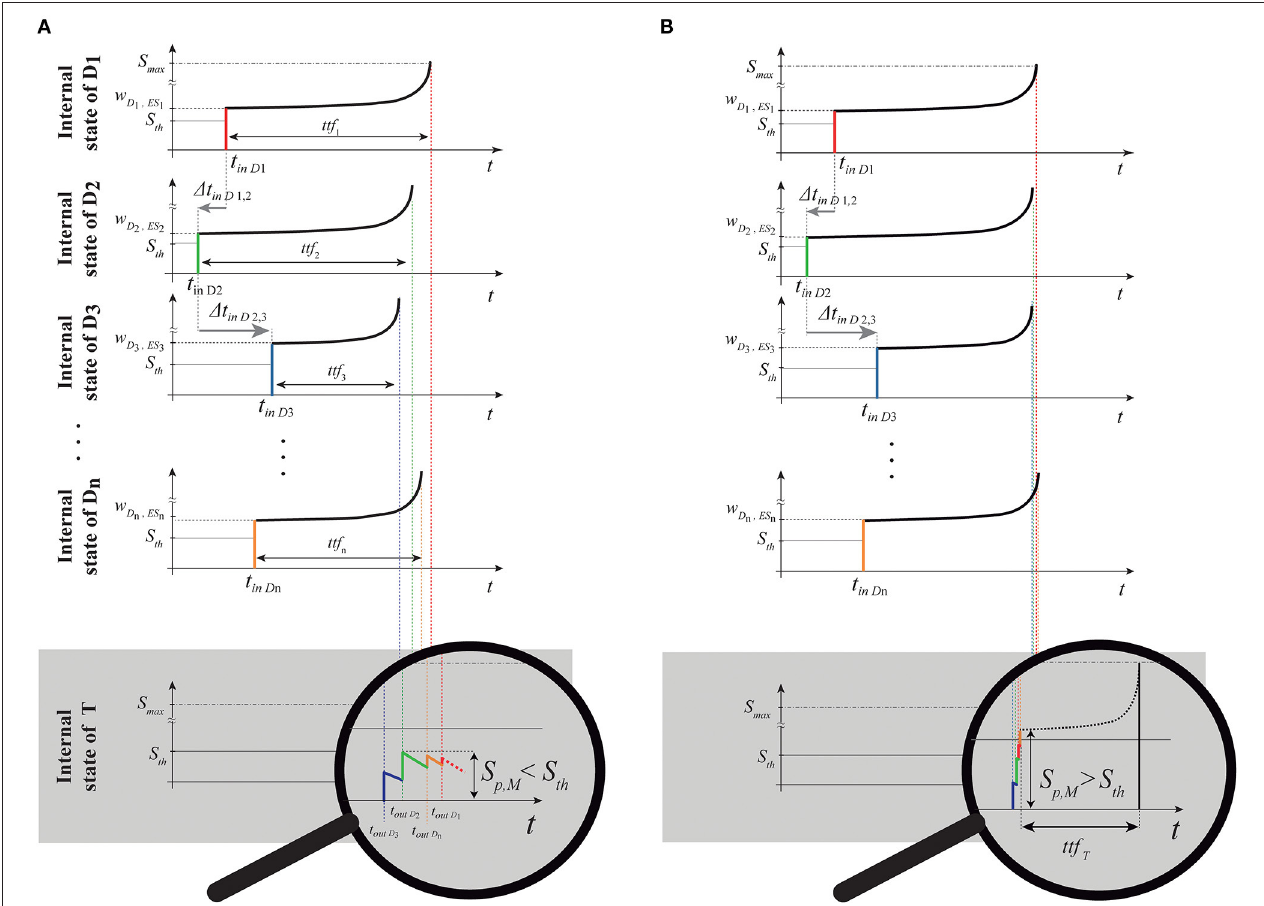
FIGURE 4 | Representation of the same spike train shown in Figures 2 , 3 passing through the delay layer and related impact on the internal state of the delay ) and relative intervals neurons D i and target neuron T . (A) Internal neuron representation ( S D ) of the absolute spike times ( t inD , t inD ,..., t inD n i 1 2 ( 1 t inD , 1 t inD ,..., 1 t inD ) of the parallel spike train. In this case, the target will not produce a spike because the simultaneity condition at the target is not reached n − 1, n 1,2 2,3 (relative intervals of the input are not coincident with the PPT of the structure); (B) we show the response of a structure with a different PPT, to the same parallel input train, which summation tends to the simultaneity condition . Consequently, such pattern is detected, and then the spike is generated. It happens after a proper time-to-fire ttf T . To show the summation process to the reader, the diagram of the internal state of the target neuron is zoomed for ease of illustration. Note that the temporal values in this internal representation are symmetrical with respect to Figures 2 , 3 since we are representing here the Cartesian temporal axis of times and not a “photography” of the parallel spike train entering the